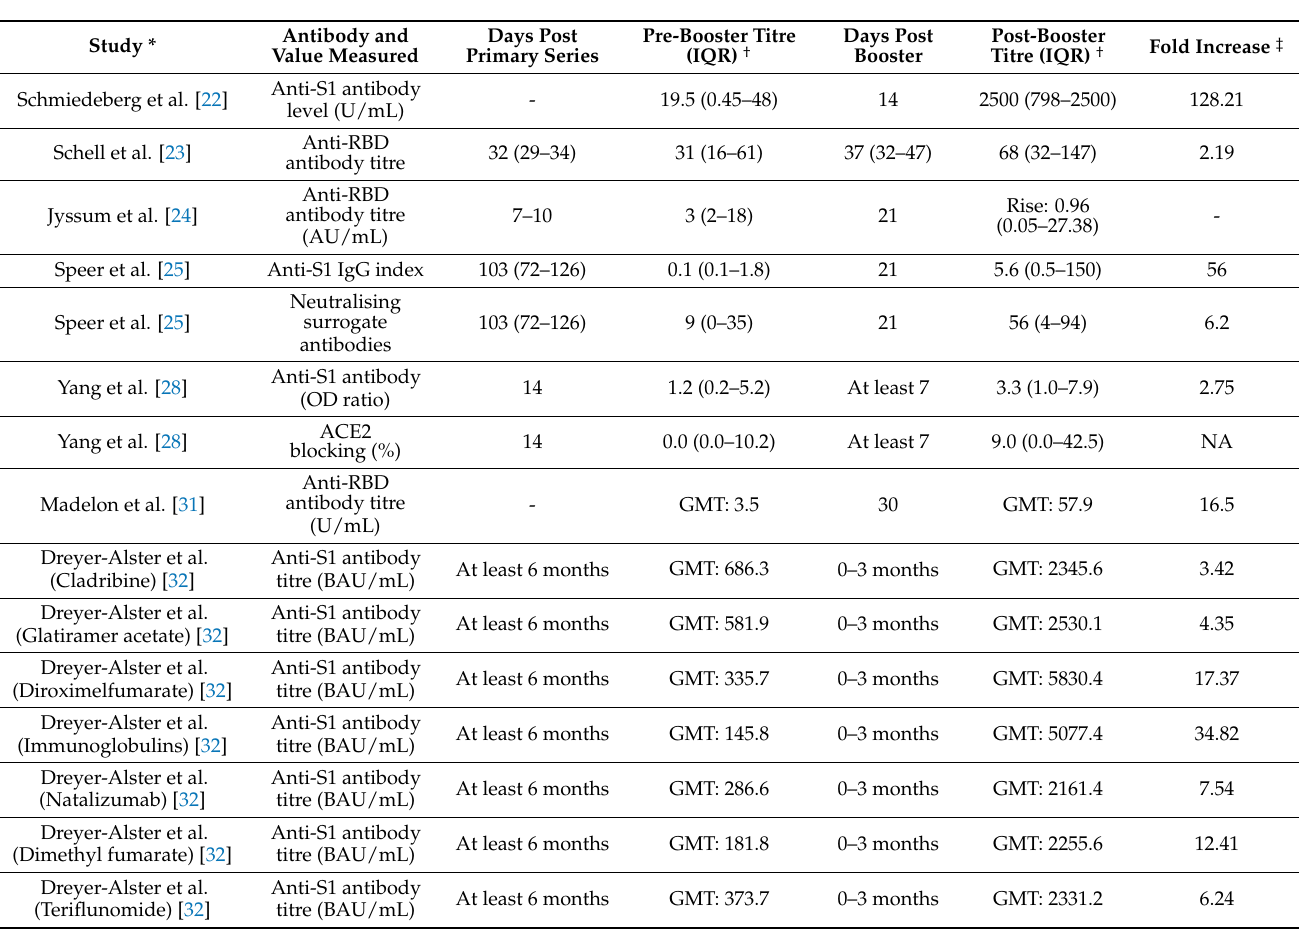
Table 3. Antibody levels after completion of primary series of COVID-19 vaccination and a booster